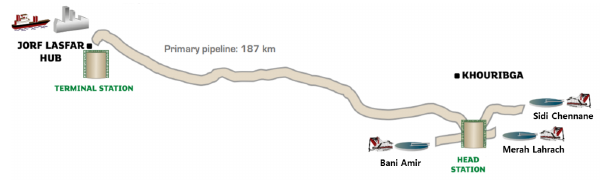
Figure 1. Study areas: phosphate mining area (Khouribga), fertilizer manufacturing area (Jorf), and transportation sys- tem (slurry pipeline) (http://www.ocpgroup.ma/ocpslurrypipeline/ slurry-pipeline, last access: 10 September